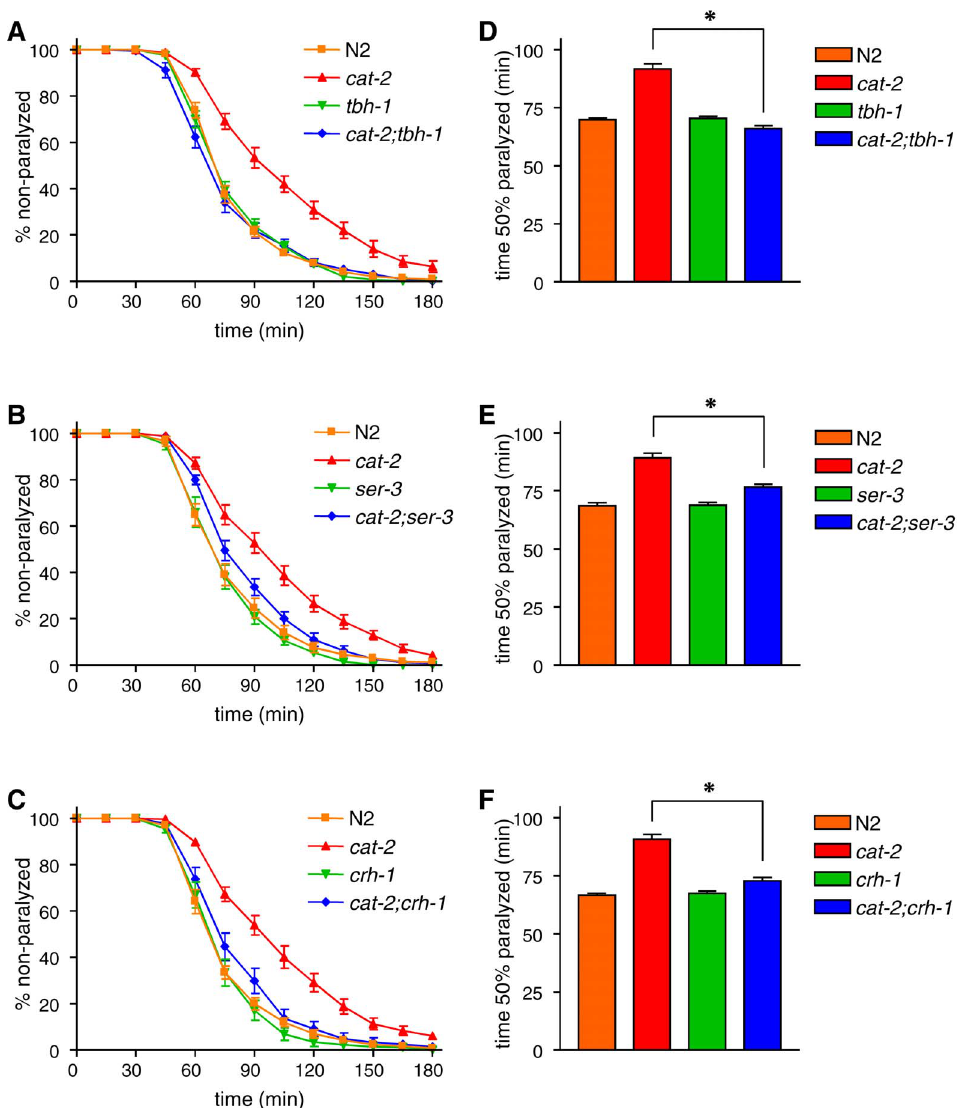
Figure 2. tbh-1 , ser-3 , and crh-1 suppress cat-2 . Double mutants for cat-2 and tbh-1 (A), ser-3 (B), or crh-1 (C) were examined for paralysis on NGM plates containing 1 mM aldicarb. (D-F) The time required for 50% of the animals to become paralyzed was determined using Prism. tbh-1 , ser-3 , and crh-1 single mutants exhibited similar aldicarb sensitivity to wild-type N2 animals. The aldicarb resistance observed in the cat-2 mutant was significantly reduced in the cat-2;tbh-1 , cat-2;ser-3 , and cat-2,crh-1 double mutants. *P , 0.001 by the Tukey-Kramer multiple comparison test. Error bars indicate the SEM. doi:10.1371/journal.pone.0072578.g002 spread over the plates, except when the animals were tested in the absence of food. The plates were allowed to dry without lids for at least 1 h and stored at 20 u C overnight to grow the bacteria. To prepare the animals used in the assays, an adult animal was placed on an NGM plate seeded with OP50. The plate was incubated at 20 u C for 4 days to allow most of the F1s to become adults. Approximately 25 adult animals on the culture plates were transferred with a platinum wire to an aldicarb or levamisole assay plate. The animals were examined every 15 min and scored as paralyzed if they did not move after being prodded with a platinum wire. The experimenter was blinded to the genotypes of the tested animals. Each assay was done in duplicate and repeated at least four times.